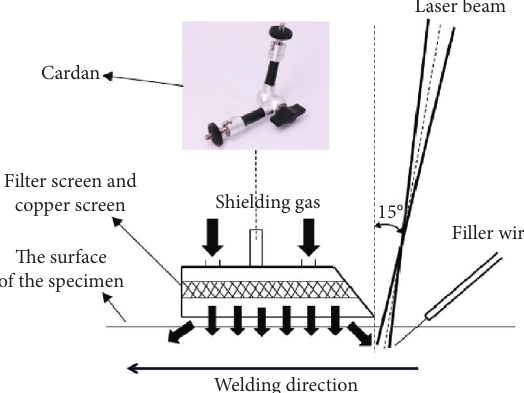
Figure 3: Experimental set-up of narrow gap laser welding.